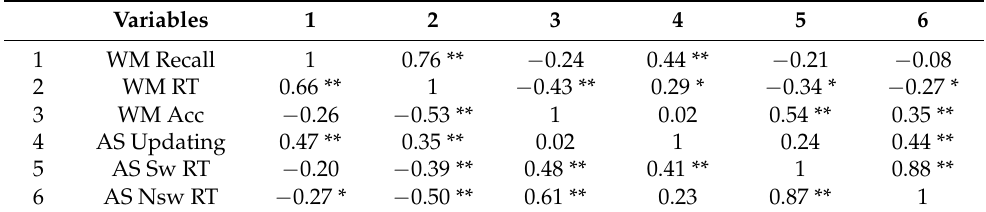
Table 2. Correlation among measures in quiet (below the diagonal) and noise (above the diagonal).